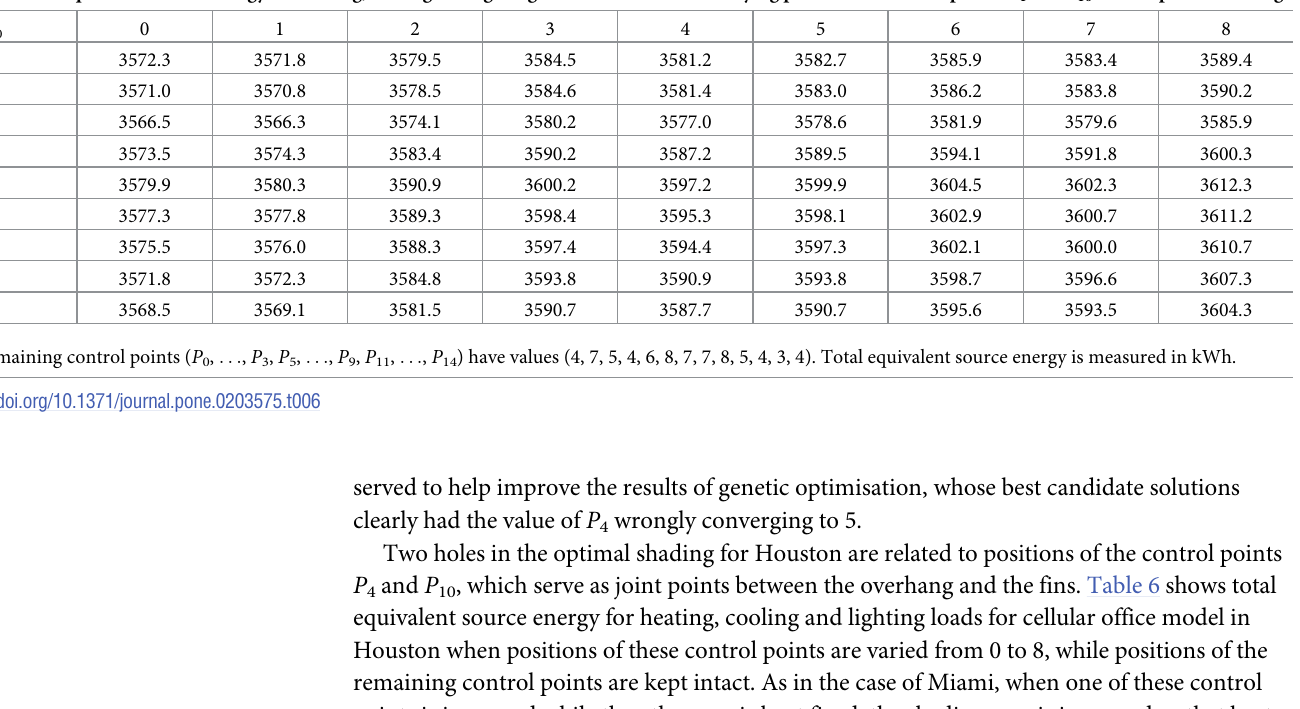
Table 6. Total equivalent source energy for heating, cooling and lighting loads in Houston for varying positions of control points P 4 and P 10 in the optimal shading.